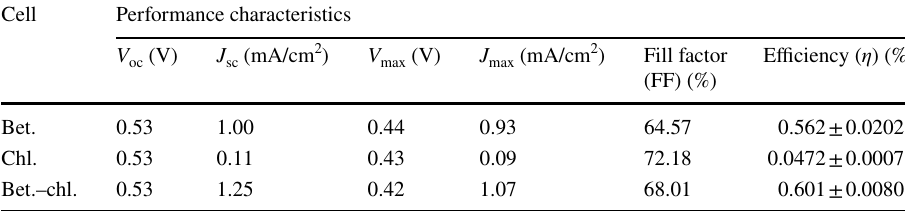
Electron lifetime ( τ ) is calculated using Eq. (2) by plugging in R TiO 2 , Q TiO 2 and α values, all of which are denoted in bold in the Cell Performance characteristics of the three solar cells being studied